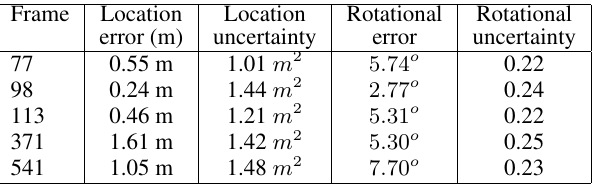
Table 2. Errors and uncertainties corresponding to Figure